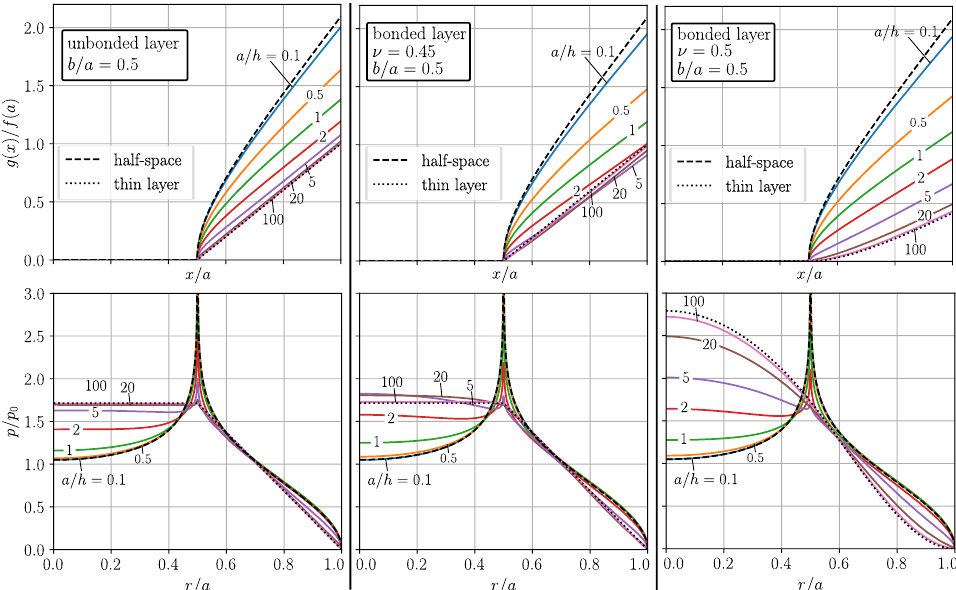
Figure 7. Normalized MDR-profile and normalized contact pressure of a truncated cone with b / a = 0.5 for an unbonded layer, a bonded layer with ν = 0.45 and a bonded incompressible layer at different confinement ratios a / h